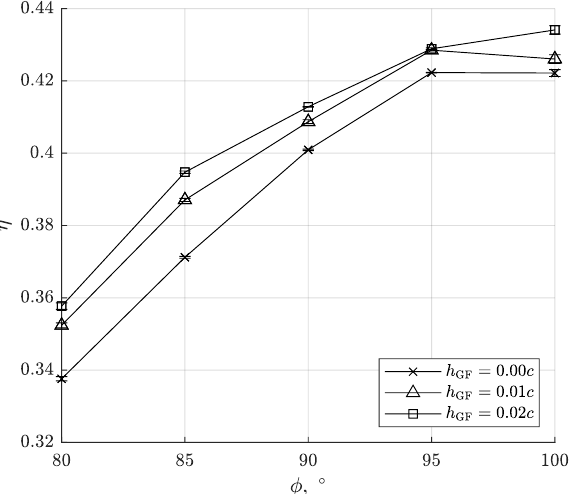
Figure 13. Effect on performance of fitting double GFs on OFTs with different motion phases at f ∗ = 0.18 and α 0 = 29 ◦ .